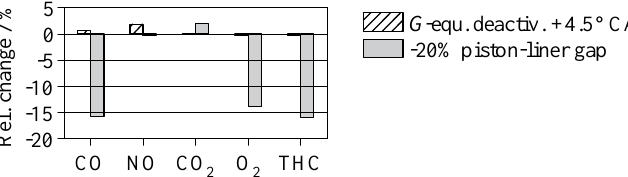
Figure 11. Relative change in species mass flows through the exhaust valves in the exhaust stroke in case of: later G -equation deactivation ( G -equ. deactiv.) (hatched bars) and -20% piston-liner gap (grey bars). Operating point